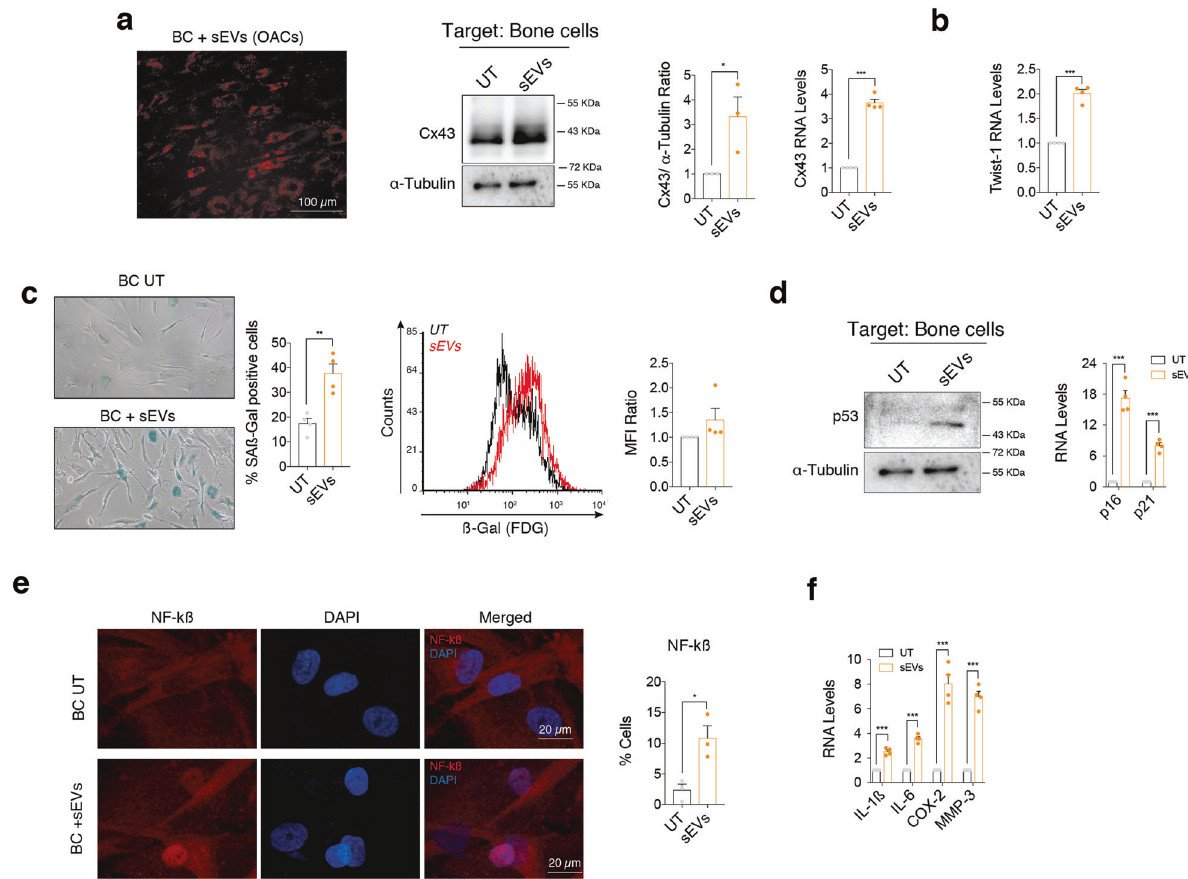
Fig. 7 sEVs secreted by OA-derived chondrocytes promote in fl ammation and senescence in bone cells. a Red Dil-labelled sEVs isolated from OA-derived chondrocytes were detected in bone cells (BC) after 48-h treatment. Cx43 protein (middle; n = 3, Student ’ s t test) and RNA (right, n = 4; Student ’ s t test) levels were upregulated in bone cells treated with sEVs derived from OA-derived chondrocytes, as determined by western blot and RT-qPCR, respectively. b RNA levels of the EMT-transcription factor Twist-1 were also signi fi cantly upregulated in bone cells after a 48-h treatment with sEVs from OA chondrocytes. n = 4, Student ’ s t test. c Senescence-associated β -galactosidase activity (SA- β -Gal) was detected by microscopy (left; n = 4, Student ’ s t test) and fl ow cytometry (right; n = 4 Student ’ s t test) in bone cells treated for 48 h with sEVs derived from OA-derived chondrocytes. d Western blot analysis showed increase p53 protein levels in bone cells treated with sEVs isolated from OA-derived chondrocytes. On the right, gene expression levels of the senescence markers p16 and p21 were upregulated in BC after a 48-h treatment with sEVs from OA chondrocytes. n = 4, Student ’ s t test. e Treatment of BC with sEVs isolated from OA-derived chondrocytes for 48 h promoted NF-k β nuclear translocation, as detected by immuno fl uorescence. n = 3, Student ’ s t test. f Overexpression of SASP factors IL-1 β , IL-6, COX-2 and MMP-3 in BC treated for 48 h with sEVs isolated from OA-derived chondrocytes. n = 4, Student ’ s t test. Data are expressed as mean ± S.E.M., * P < 0.05, ** P < 0.01, *** P <